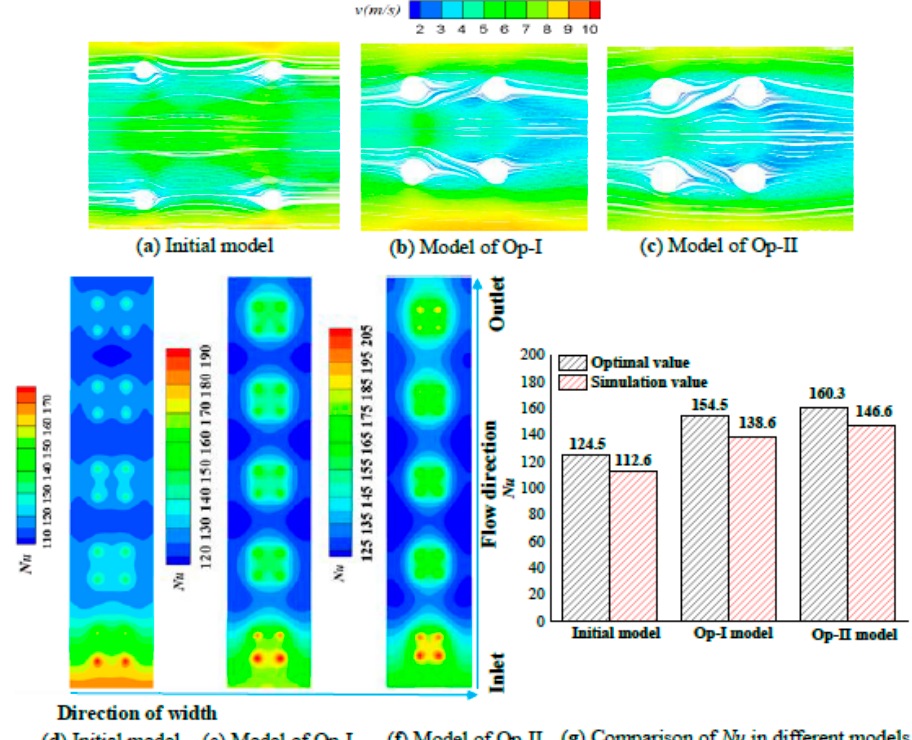
Figure 13. Streamline of the target surface, Nu distribution of the target surface, and Nu comparison: ( a ) Initial model; ( b ) model of Op-I; ( c ) model of Op-II; ( d ) initial model; ( e ) model of Op-I; ( f ) model of Op-II; and ( g ) comparison of Nu in different models.